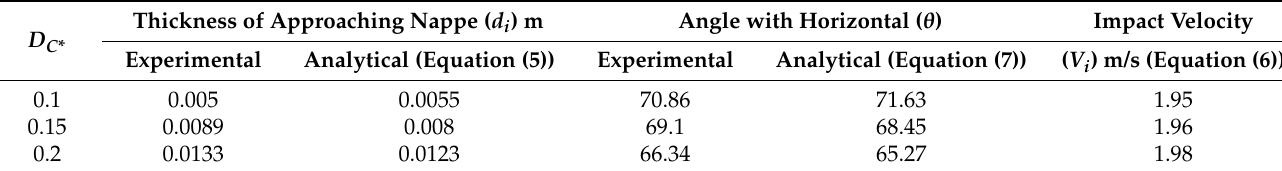
Table 2. Analysis of experiments.